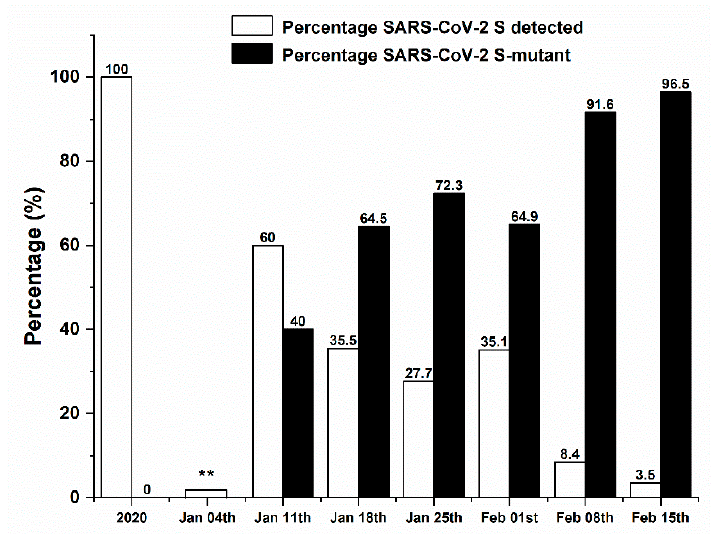
Figure 3. Percentage of classic strain vs. S -mutant variant(s) among SARS-CoV-2 positive cases. ** Missing